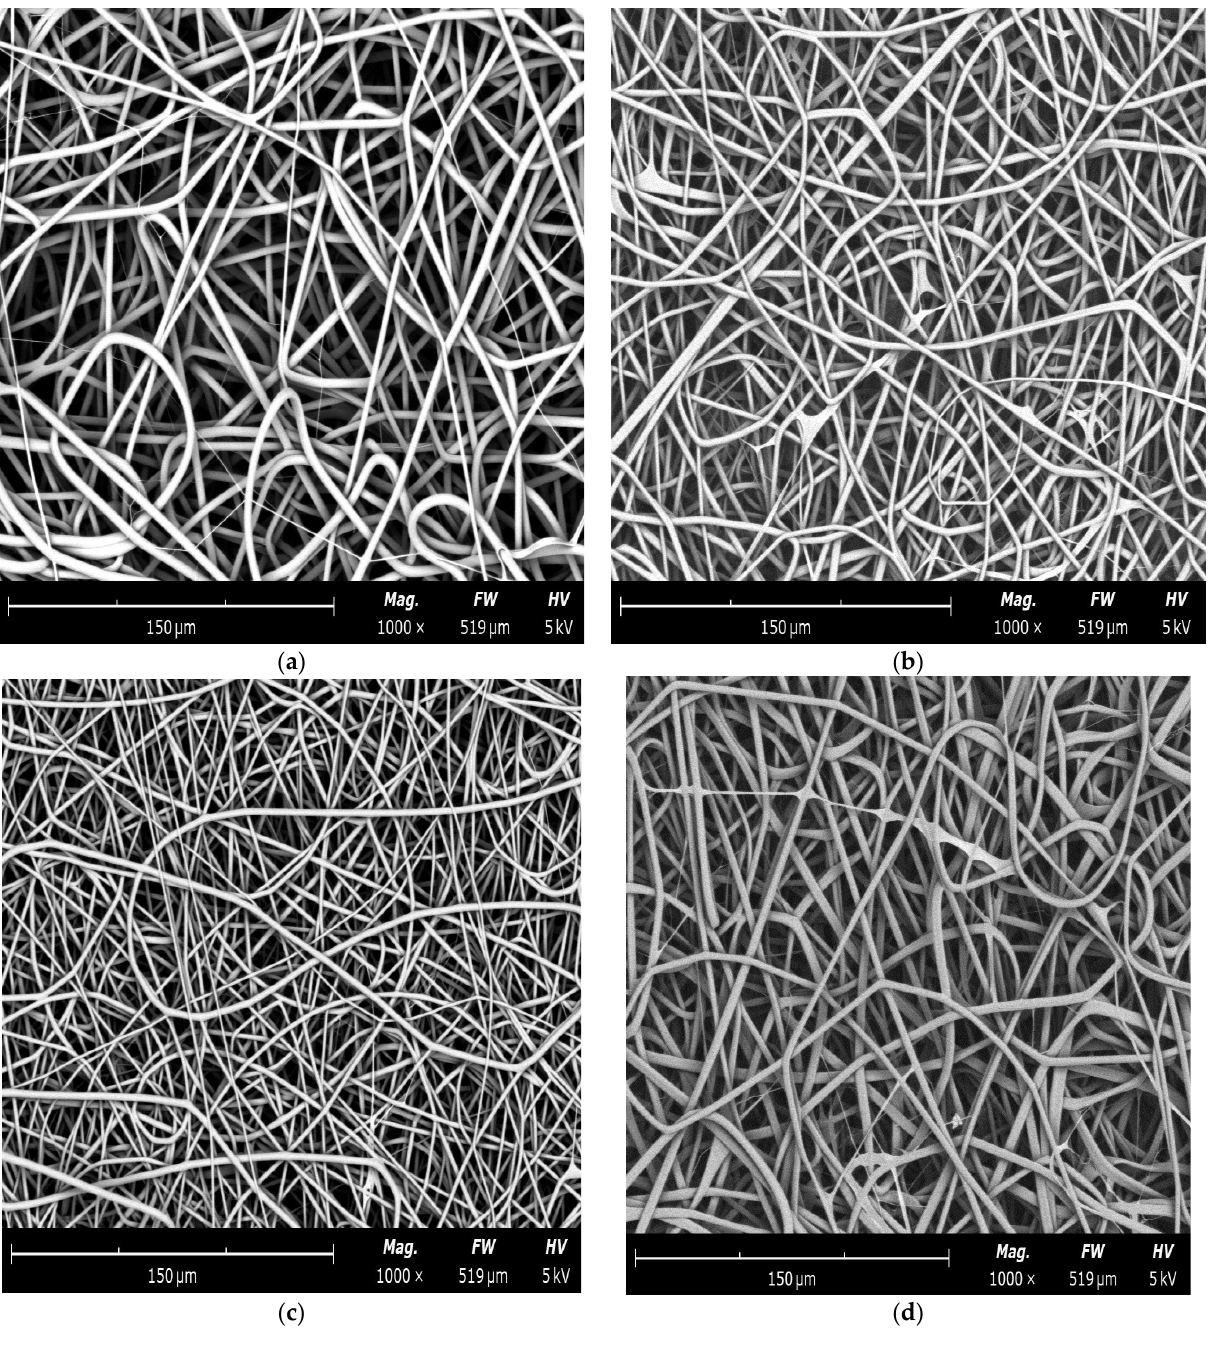
Figure 2. SEM images of the ES fibrous mats: ( a ) ESf2 ; ( b ) ESf3 ; ( c ) ESf4 ; and ( d ) ESf5 .